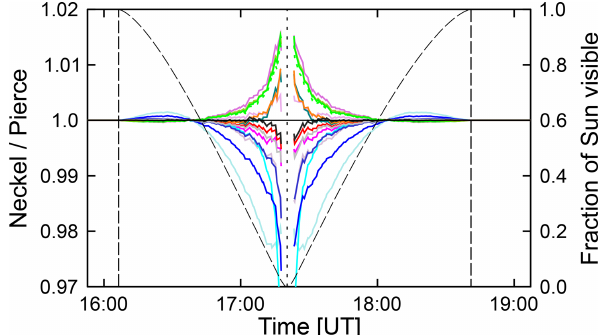
Figure 10. Ratio of the LD effect calculated with the parameter- izations by Neckel and Pierce. The color coding is identical with that used in Fig. 8. The dashed line indicates the fraction of the Sun’s disk that is visible and is referenced to the right axis. Vertical dashed lines indicate the first and fourth contact.